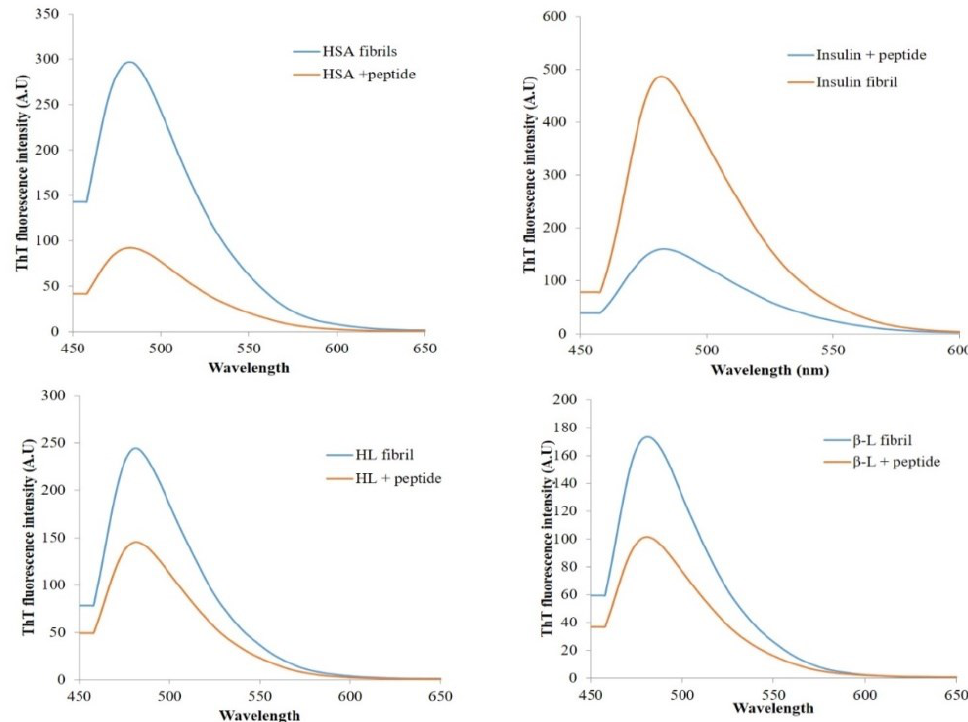
Figure 4. ThT fluorescence